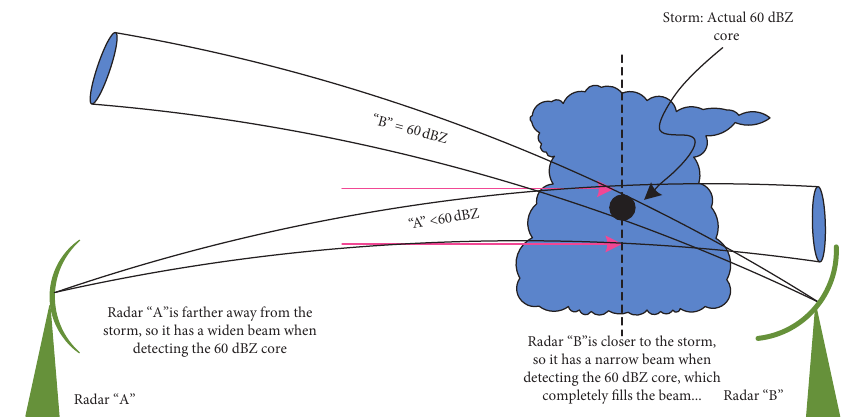
Figure 1: The effect of beam